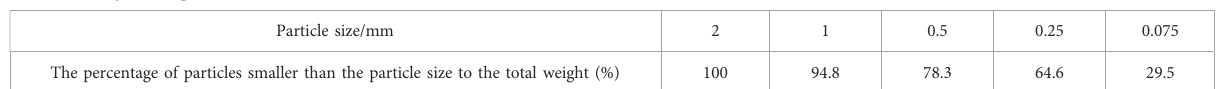
TABLE 2 The particle gradation of the CBS.